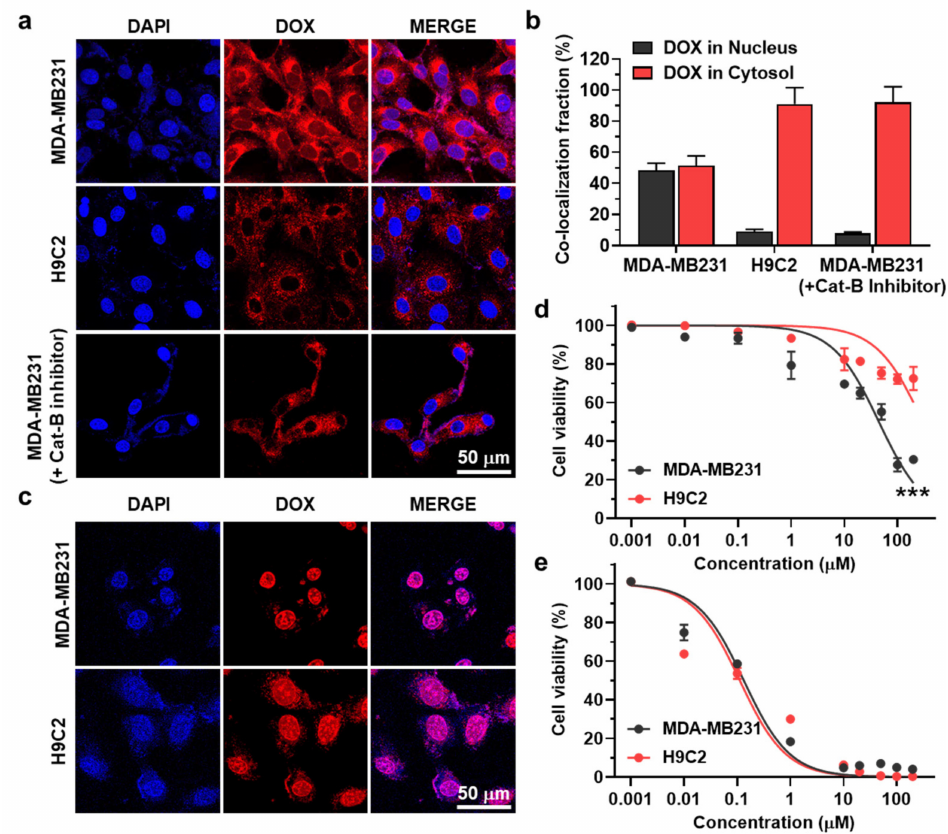
Figure 3. Cellular uptake and cytotoxicity of Al-ProD. ( a ) Fluorescence images of MDA-MB231 and H9C2 cells treated with Al-ProD. As a control, MDA-MB231 cells were pre-incubated with cathepsin B-inhibitory siRNA. ( b ) Quantification analysis of DOX fluorescence in nuclei or cytosol of Al-ProD- or free DOX-treated MDA-MB231, H9C2, and cathepsin B-inhibitory siRNA-treated MDA-MB231 cells. ( c ) Fluorescence images of MDA-MB231 and H9C2 cells treated with free DOX. ( d , e ) Cytotoxicity of ( d ) Al-ProD or ( e ) free DOX in MDA-MB231 and H9C2 cells. Significance (*** p < 0.001) was determined by Student’s t -test ( d